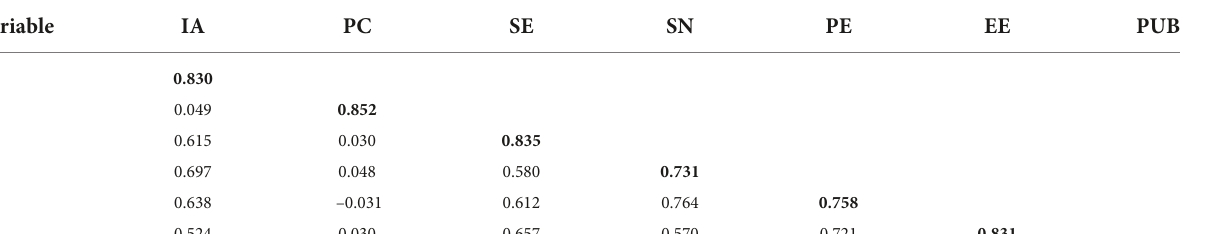
TABLE 7 Correlations for latent variables and the square root of